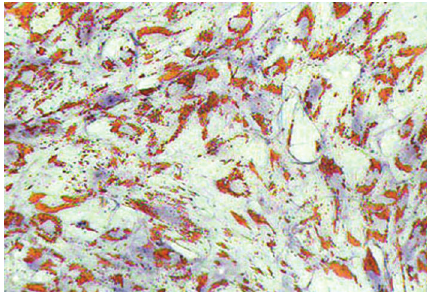
Figure 6: Calcium salinity accumulated after induced culturing (100 × ).